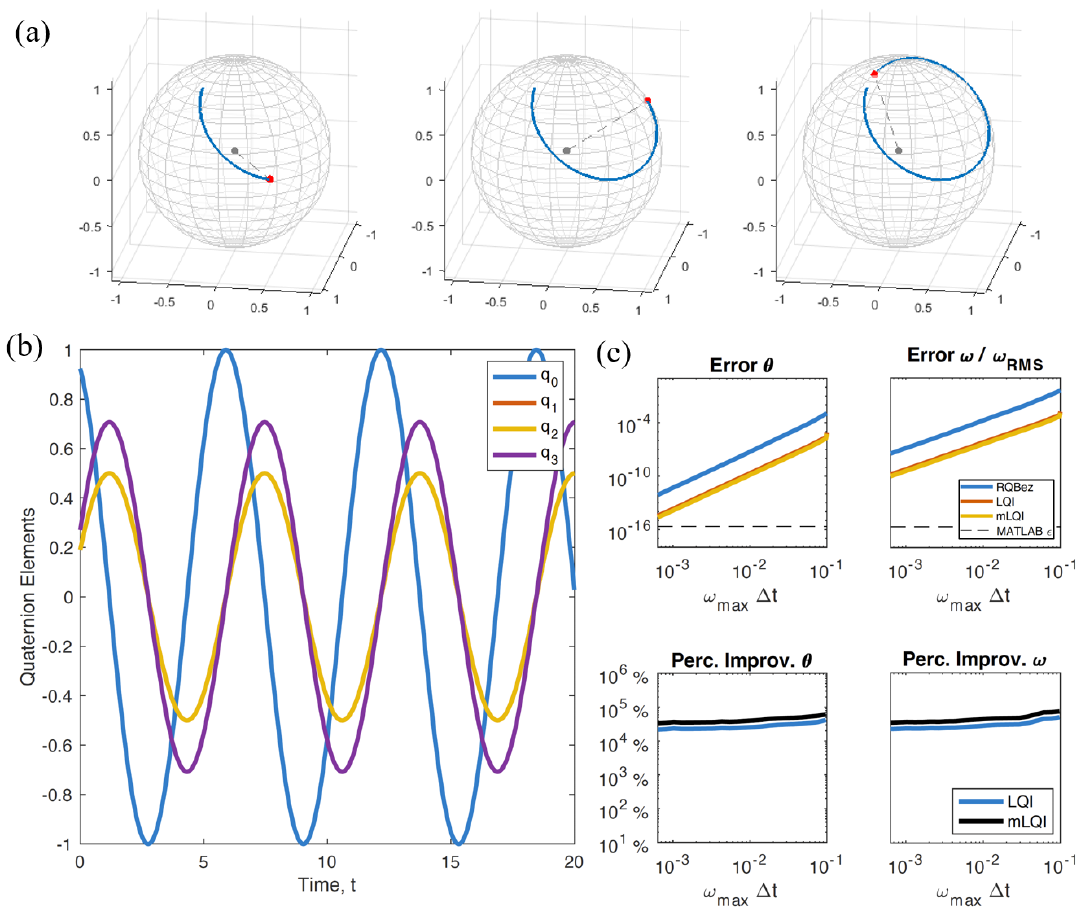
Figure 2. ( a ) The rotational motion of ˆ r 0 = ˆ z as a result of constant rotation in the quaternion angle. √ (cid:104) 1,1, Here, ω θ = 2 rad , ˆ n = 1 2 (cid:105) . ( b ) What the quaternion elements themselves look like as a function s 2 of time. Simple rotation means sinuisodal variation ( c ) Error in the angle θ and the magnitude of angular momentum (cid:107) (cid:126) ω (cid:107) ( α = 0), both in absolute magnitude and relative to RQBez. Both LQI and mLQI outperform RQBez by over three orders of